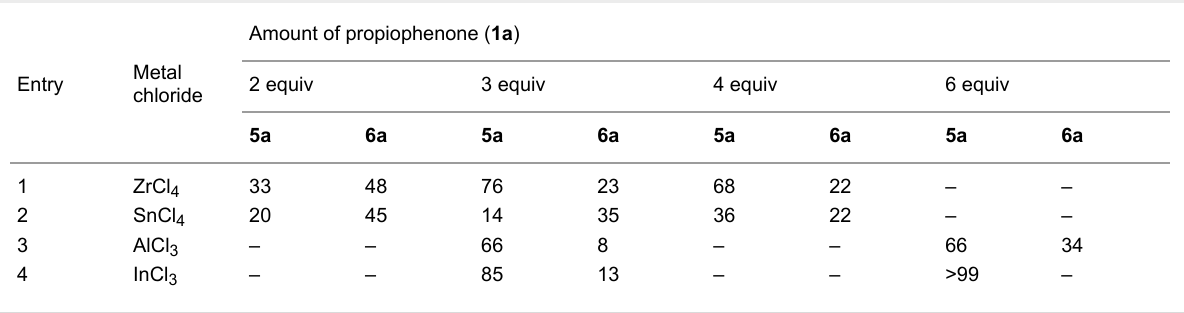
Table 2: Dependence on the stoichiometric amount of propiophenone ( 1a ) enolate with regard to the metal (reaction time: 2 h, reaction temperature: 25 °C, 5a / 6a in %).